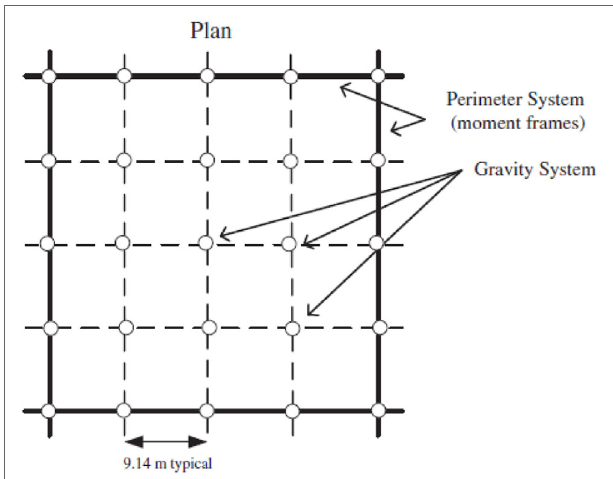
Figure 6 | Plan view of 4-, 8-, and 16-storey frame to be used in pushover analyses (Ghassemieh and Kiani, 2012) reproduced with permission from the copyright holder.